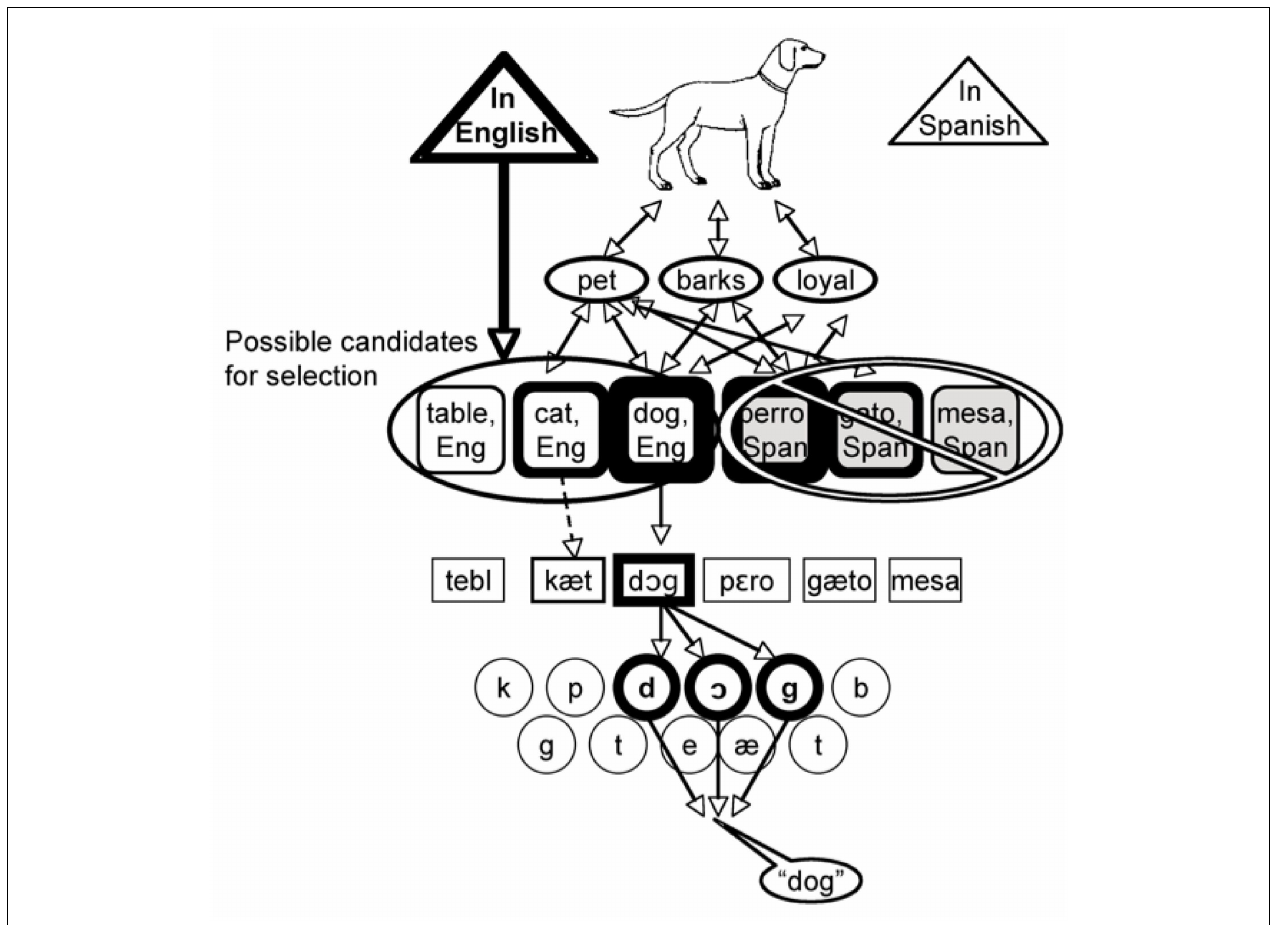
FIGURE 8 |A schematic illustration of the language-specific selection model (Costa, 2005). Lexical candidates in Spanish may become active,